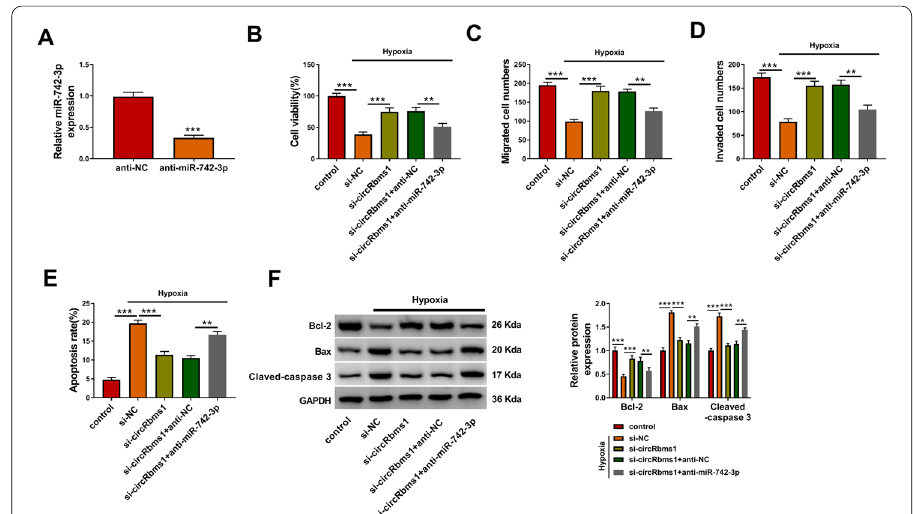
Fig. 5 Effects of circRbms1 silencing and miR-742-3p inhibitor on hypoxia-induced H9c2 cell injury. A After transfecting with anti-NC (50 nM) or anti- miR-742-3p (50 nM) into H9c2 cells, the expression of miR-742-3p was assessed by qRT-PCR. B–F H9c2 cells were transfected with si-NC (50 nM), si- circRbms1 (50 nM), si- circRbms1 (50 nM) anti-NC (50 nM), or si- circRbms1 (50 nM) anti- miR-742-3p (50 nM), and then treated with hypoxia. + + Untreated H9c2 cells were used as control. CCK8 assay ( B ), transwell assay ( C , D ), and flow cytometry ( E ) were employed to examine cell viability, migrated and invaded cell numbers, and cell apoptosis rate, respectively. F WB analysis was used to test the protein levels of Bcl-2, Bax, and Cleaved-caspase 3. All experiments were repeated three times. ** P < 0.01, *** P <